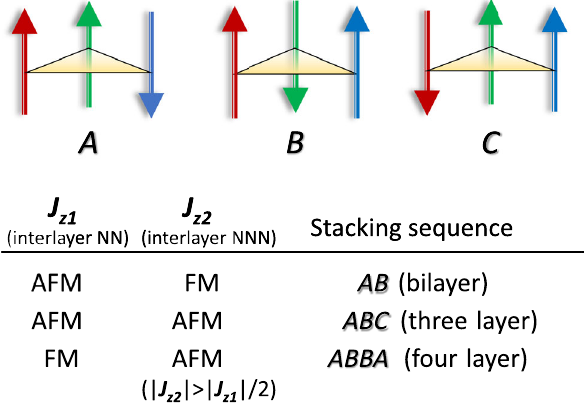
FIG. 19. The three possible plateau state configurations due to geometric degeneracy of triangular layer: A ( uud ), B ( udu ), or C ( duu ). The spin-stacking sequence of the successive triangular layer is determined by the nature (AFM or FM) and relative strengths of nearest-neighbor (NN) ( J ) and z 1 second-nearest-neighbor (NNN) ( J ) interlayer z 2